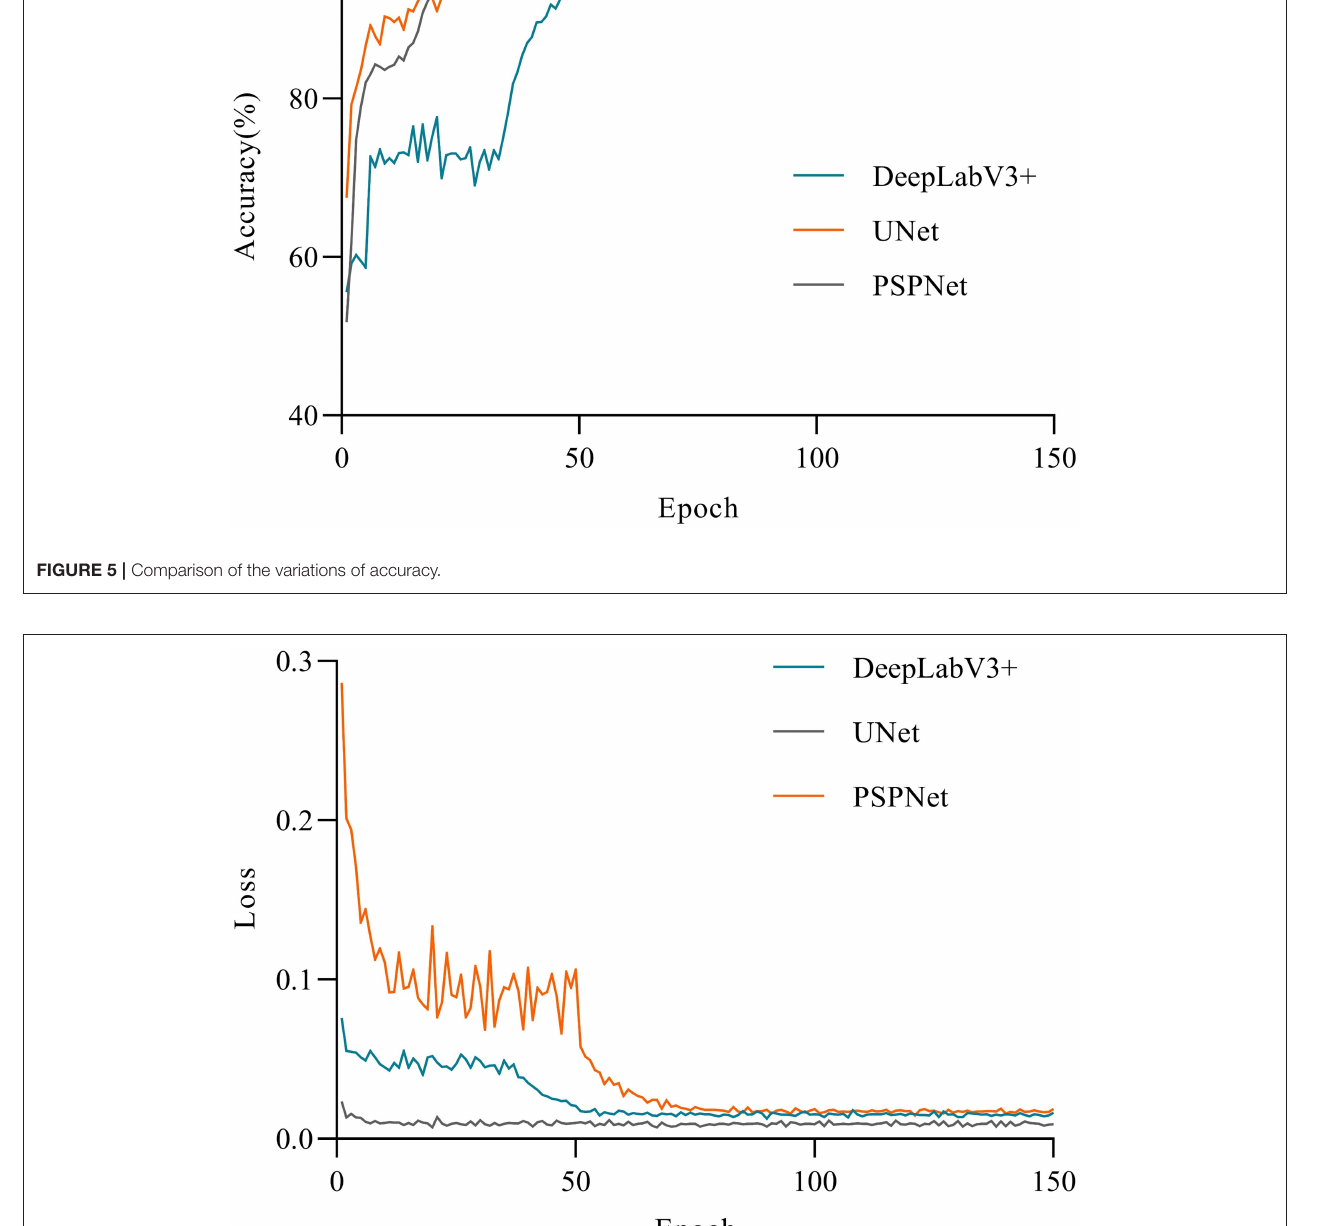
FIGURE 6 | Comparison of the variations of